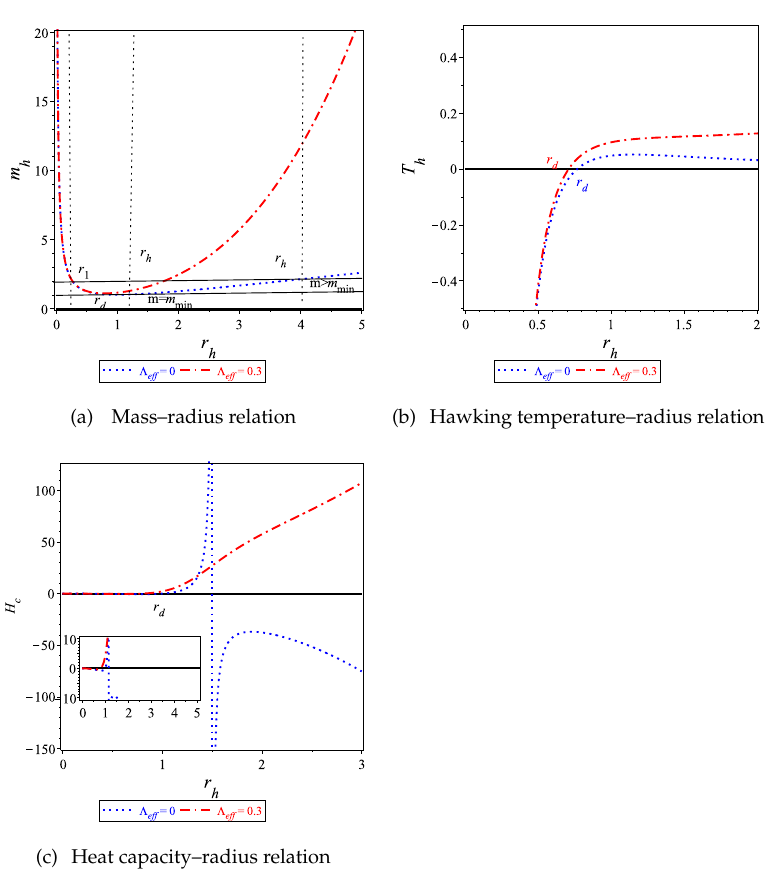
Figure 2. Plots of thermodynamical quantities of BHs. ( a ) The mass-radius relation, which determines the minimal mass. ( b ) The hawking temperature, which vanishes at r h . ( c ) The heat capacity. Moreover, the linear case investigates a second-order phase transition. All the figures are plotted for m h = q =